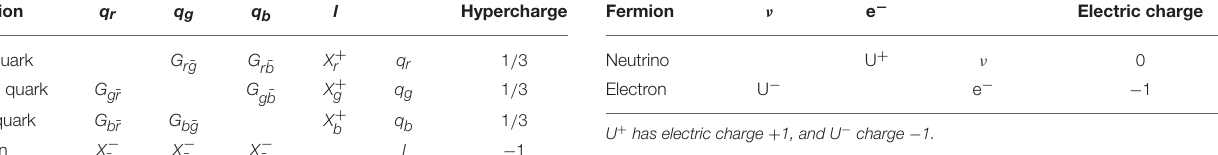
TABLE 2 | SU(2) representation for exchange of neutrino with electron by help of the U gauge boson. Fermion ν e − Electric charge U + has electric charge 1, and U − charge 1. + −